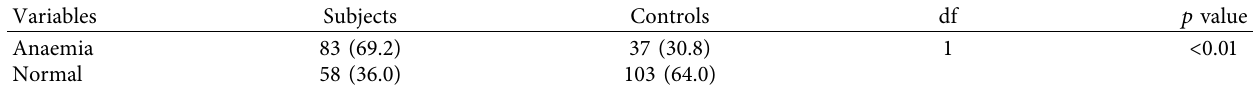
Table 6: Presence of anaemia in subjects and